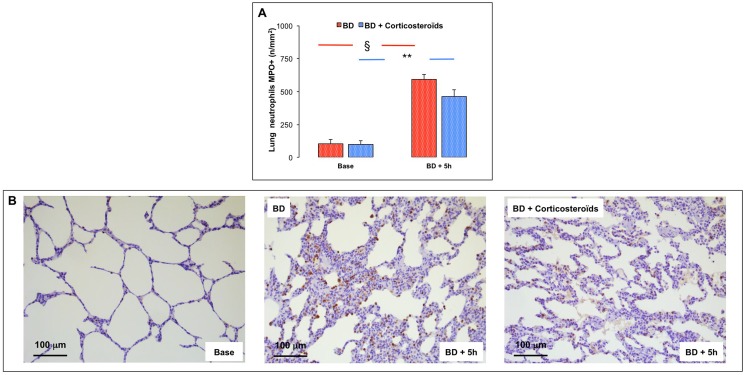
Evaluation of neutrophilic lung infiltration.Panel A: The number of extravascular neutrophils (MPO-positive cells) was determined in lung tissues at baseline, five (BD + 5 hours) hours after Cushing reflex in the placebo-pretreated brain death (BD group; n = 11; red bars) and in the methylprednisolone-pretreated brain death (BD + Corticosteroids; n = 8; blue bars) groups. Panel B: Illustrative microscopic views (magnitude 200x) of immunohistochemistry myeloperoxidase marked lung sections at baseline and at 5 hours after Cushing reflex in the BD and the BD + Corticosteroids pretreated pigs. Values are expressed as mean ± SEM. * p<0.05 BD versus BD + Corticosteroids; § p<0.05 Base versus BD + 5 hours in the BD group; ** p<0.05 Base versus BD + 5 hours in the BD + Corticosteroids group.